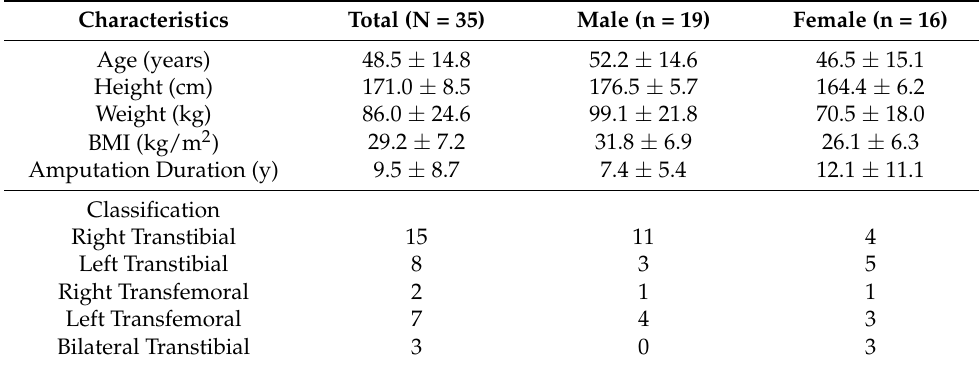
Table 1. Participant